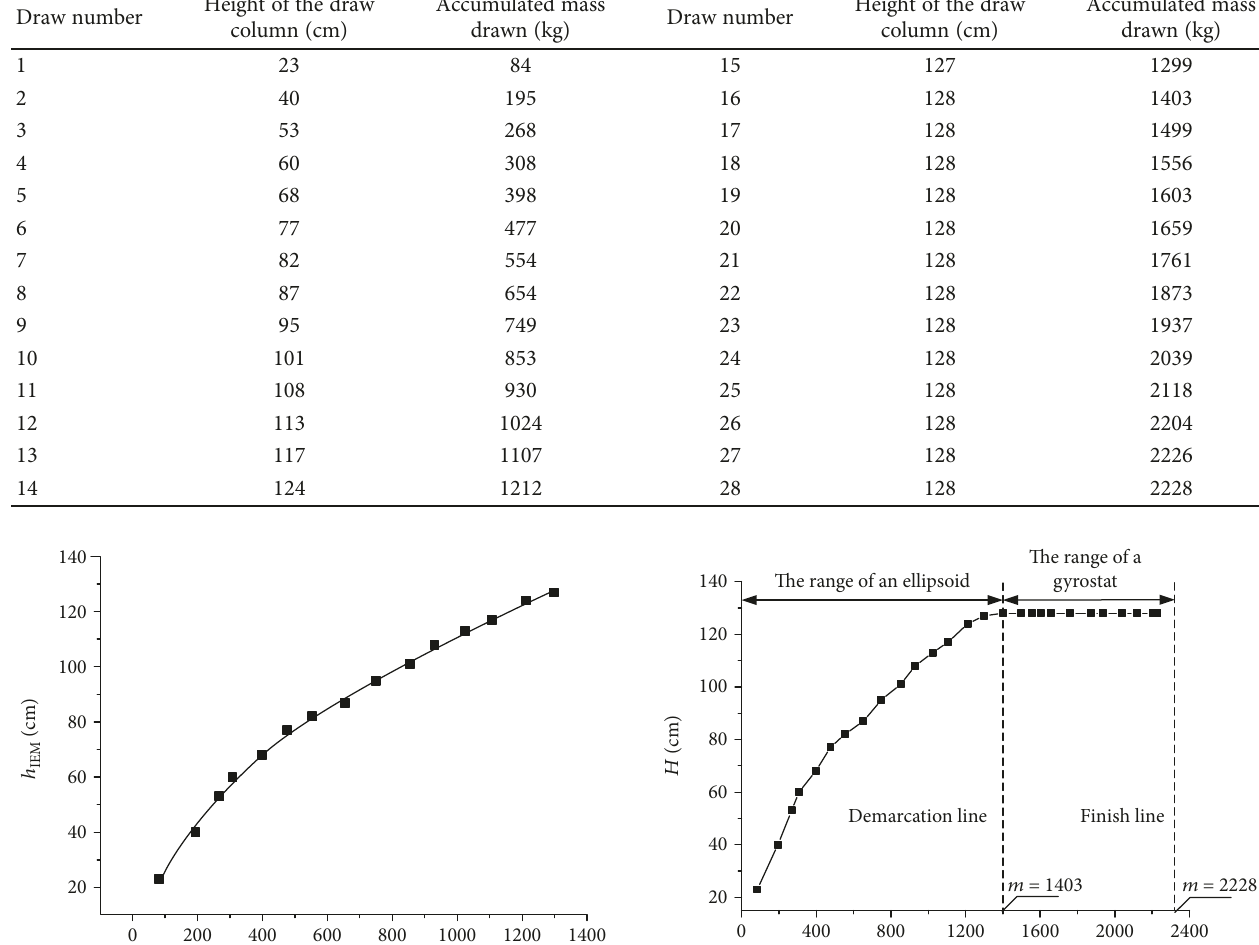
Table 6: Statistical results of the height of the draw column and the accumulated mass drawn.